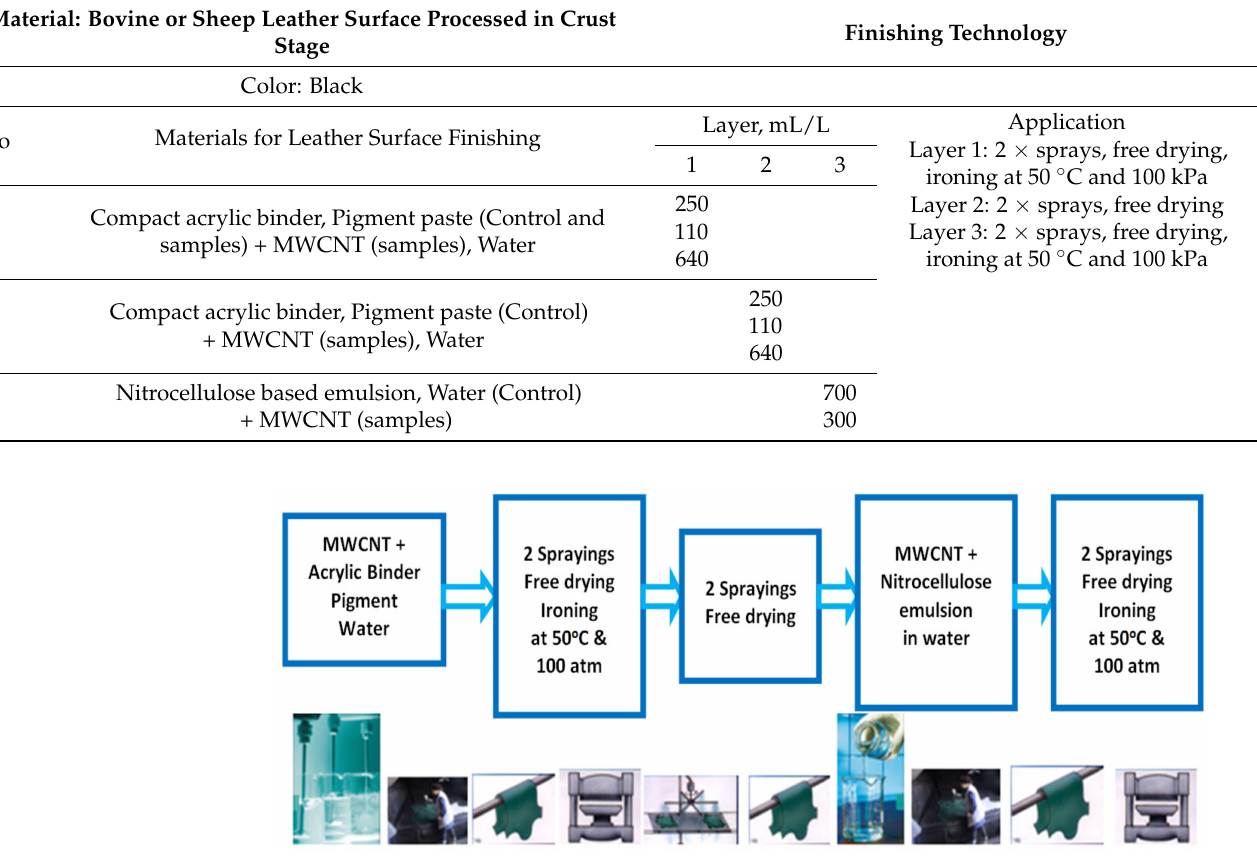
Figure 1. Leather finishing application technology [20].